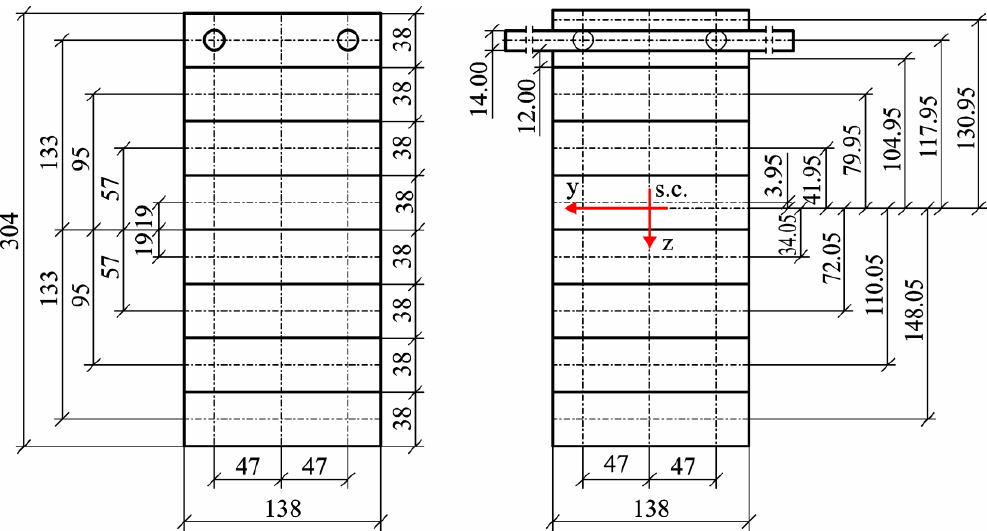
Figure 2. A schematic diagram of designed beams. Table 1. Physical and mechanical properties of tested